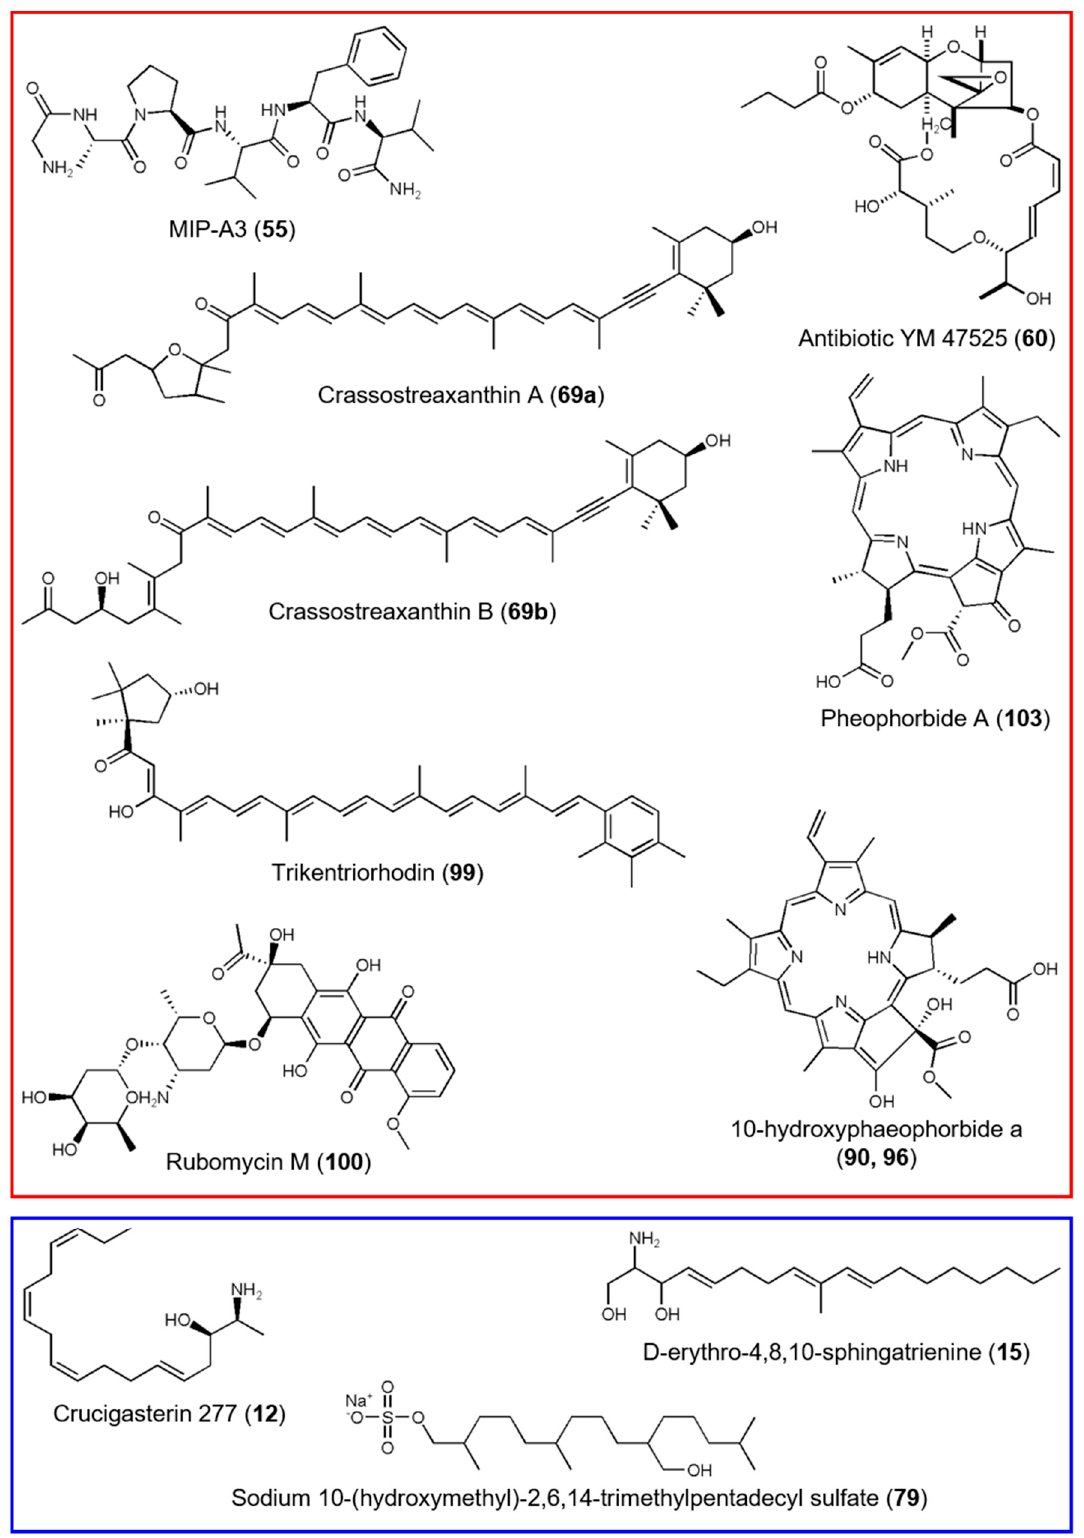
Figure 6. Metabolites with enhanced or exclusive production in C. intestinalis specimens from Canada (red) and Helgoland (blue). Peak annotation of putatively identified compounds from Canadian and Helgoland population extracts is in accordance with Table S11.